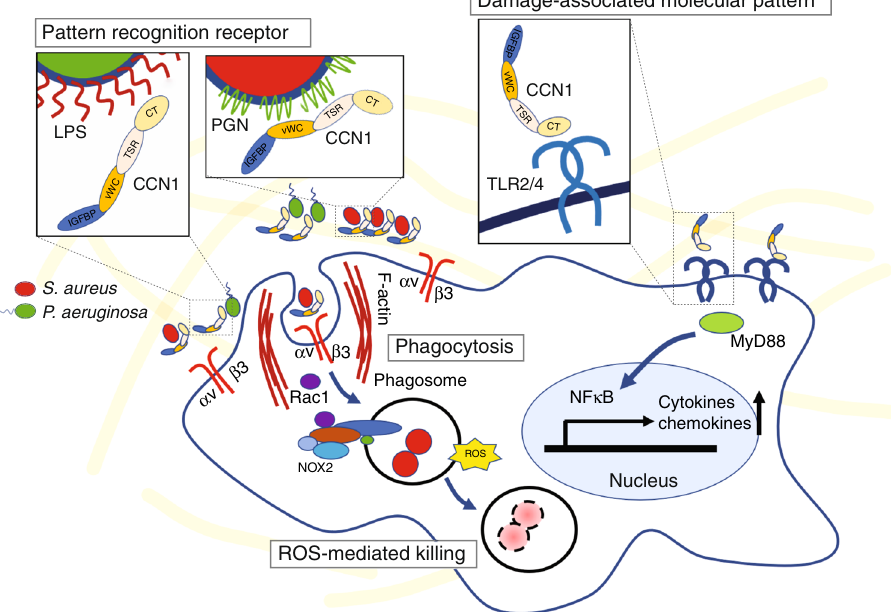
Fig. 9 Schematic of CCN1 functions in bacterial clearance and activation of TLR signaling. CCN1 functions as a PRR and opsonizes Gram-positive and Gram-negative bacteria through binding PGN and LPS, respectively. CCN1 activates phagocytosis by engagement of integrin α v β 3 in phagocytes, thereby promoting the engulfment of bacteria. In macrophages, CCN1 also stimulates ROS production through activation of Rac1 and NOX2, thus enhancing bacterial killing. Independent of the presence of bacteria, CCN1 functions as a DAMP and activates TLR2 and TLR4 by direct binding to these receptors, leading to MyD88-dependent expression of in fl ammatory cytokines and